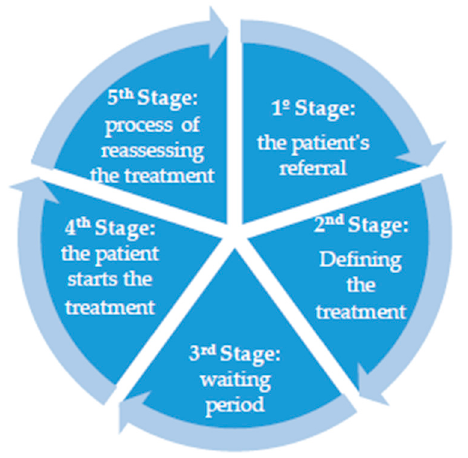
Figure 5. Flowchart of patient care in the radiotherapy sector.